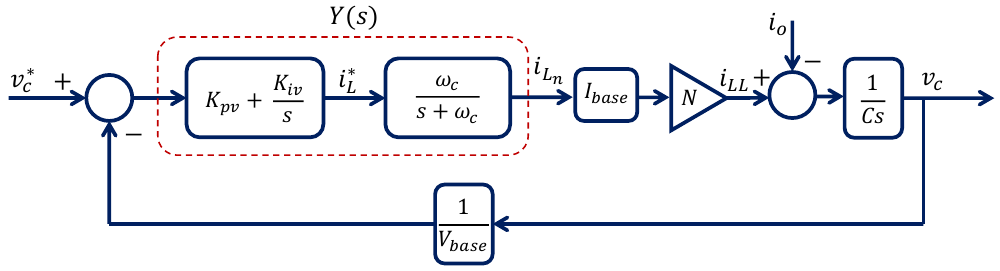
Figure 9. Block diagram used to extract the system transfer function in order to analyze the controller disturbance rejection